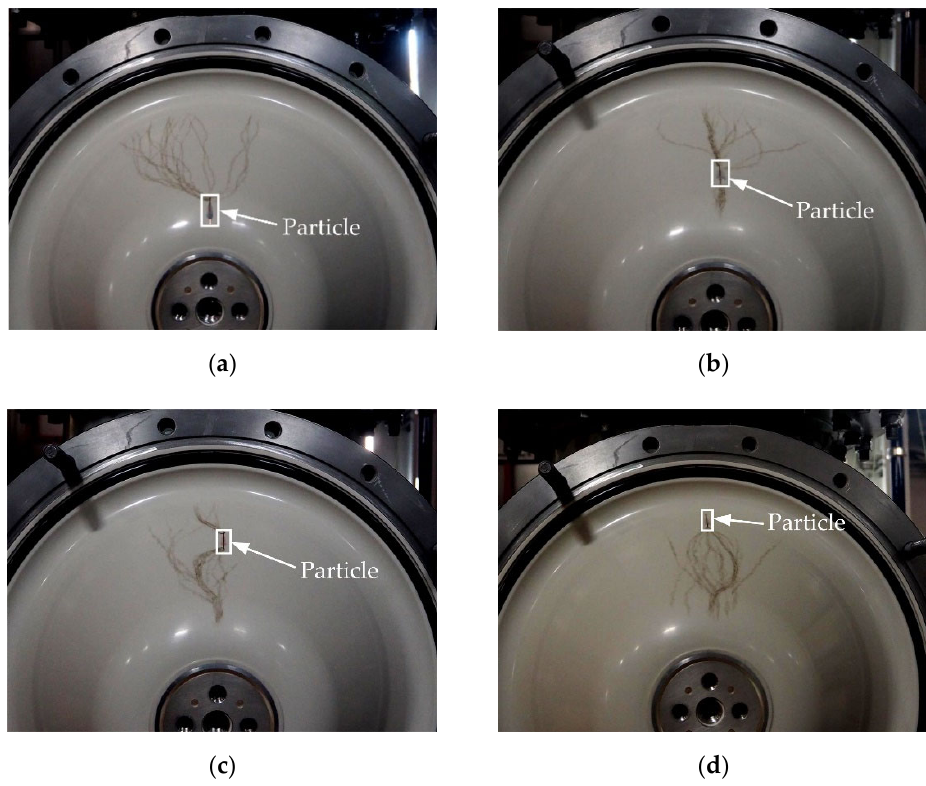
Figure 6. Images of tracking with particle at various locations. In ( a ), the particle is located at 19 mm. In ( b ), the particle is located at 71 mm. In ( c ), the particle is located at 123 mm. And in ( d ), the particle is located at 175 mm from HV electrode.